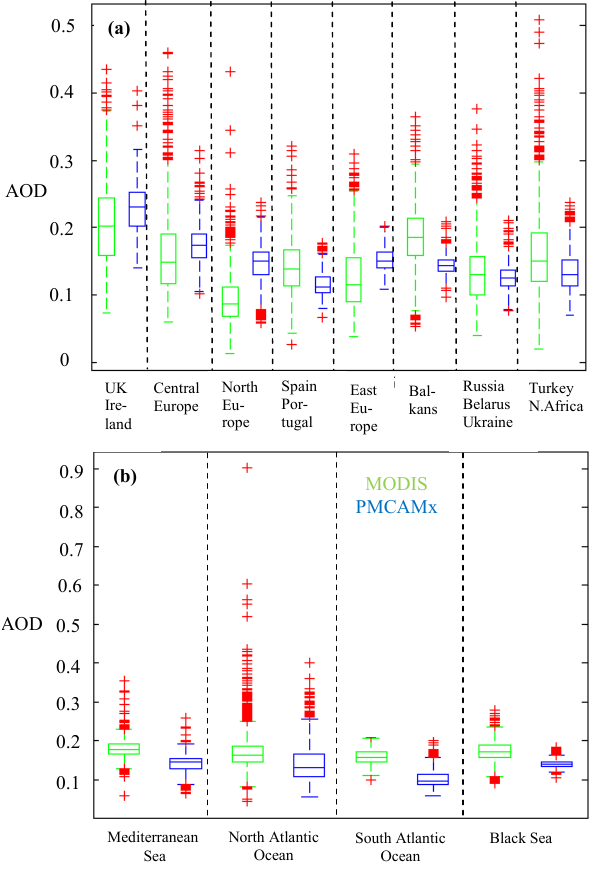
Figure 6. (a) Box plots of the PMCAMx and MODIS (QAC ≥ 1) monthly mean AODs for land. The central mark is the median, the edges of the box are the 25th and 75th percentiles, the whiskers ex- tend to the extreme data points considered not to be outliers, and the outliers are plotted individually by the red marks. Points are drawn as outliers if they are larger than Q 3 + 1 . 5 (Q 3 − Q 1 ) or smaller than Q 1 − 1 . 5 (Q 3 − Q 1 ) , where Q 1 and Q 3 are the first and third quartiles, respectively. (b) Box plots of the PMCAMx and MODIS (QAC ≥ 1) monthly mean AODs for